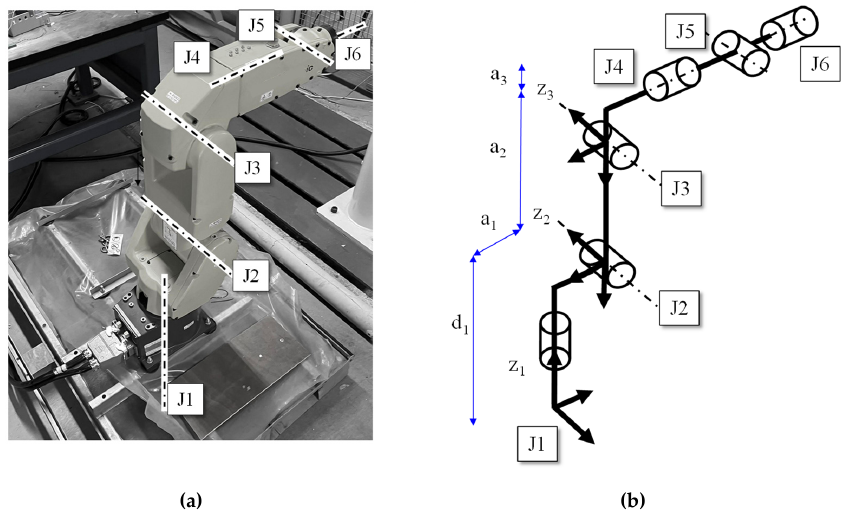
Figure 11. ( a ) FANUC LRMate200-iC and ( b ) D-H representation.